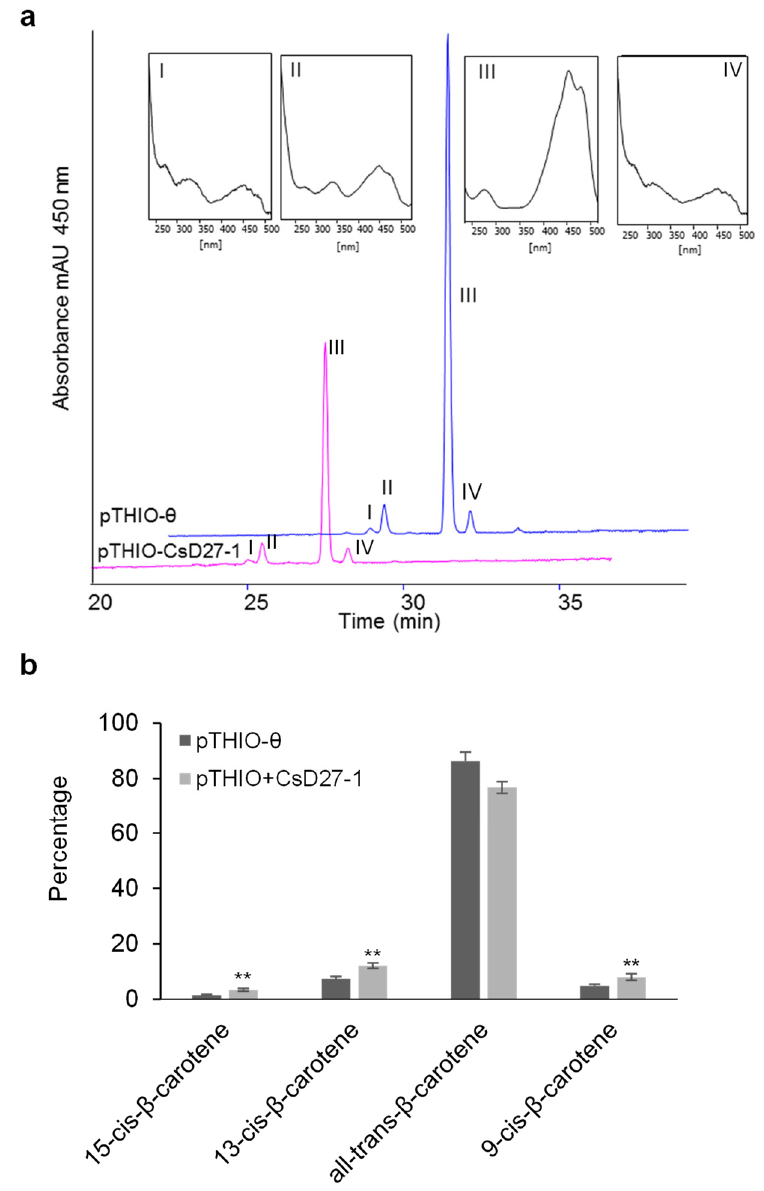
Figure 5. HPLC analysis of the reaction catalyzed by CsD27-1 in vivo on β -carotene produced by E. coli cells. ( a ) pThio+CsD27-1, converts all- trans - β -carotene (III) to 9- cis - β -carotene (IV), 13- cis - β -carotene (II) and to15- cis - β -carotene (I). ( b ) Percentages of all the cis - β -carotene isomers were significantly increased in the cells expressing the CsD27-1 enzyme. Statistical analysis was performed using student-t test. A designation of ** = p < 0.01 ( t -test). n = 3 independent biological replicate experiments. Error bars represent SD.